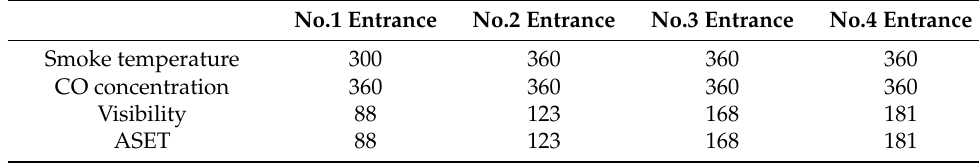
Table 4. ASET for the fire (unit: s).